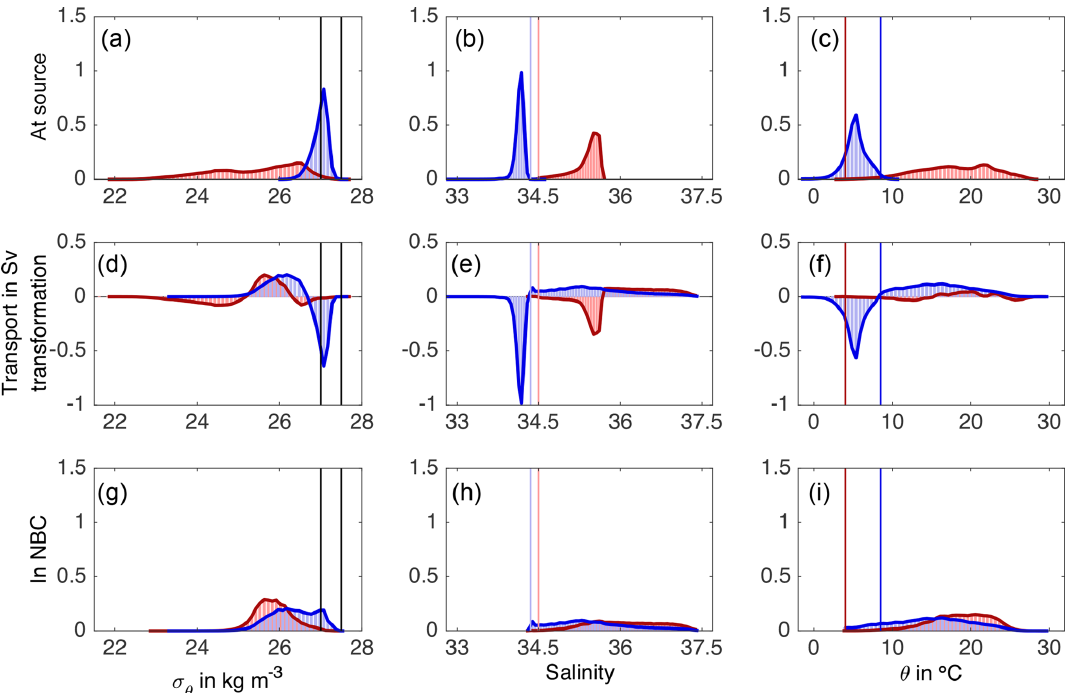
Figure 11. Same as Fig. 10 but for waters with AC and DP origin that do not enter the mixed layer during their